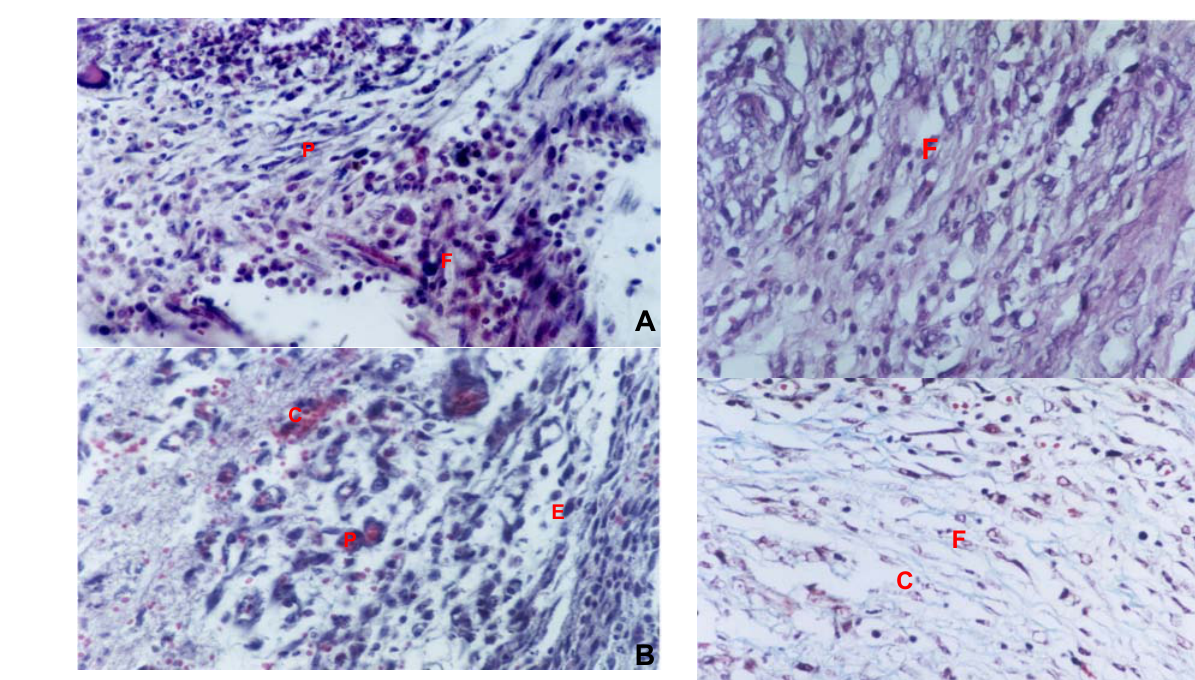
FIGURA 5 – Fotomicrografias do cólon de rato GJ 7 corado pela técnica de hematoxilina - eosina (A) e tricrômico de masson (B). Em A observa-se inflamação crônica com fibroblastos (F); em B inflamação crônica com fibroblastos (F) e colágeno